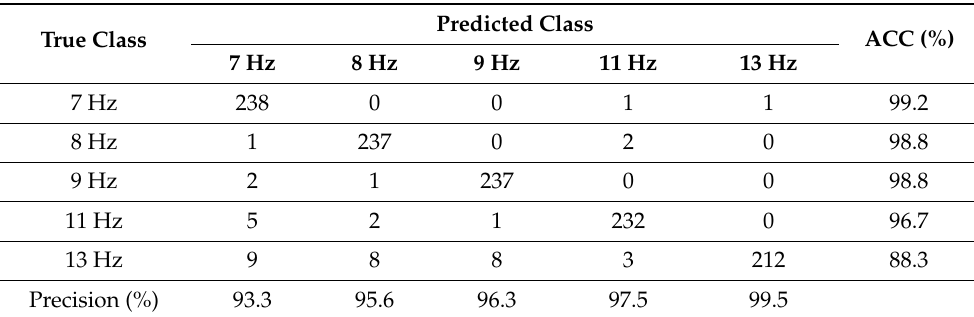
Table 12. The confusion matrix for the SSVEP recognition results using MSI classifier for the map test in the second experiment (Scenario 3).